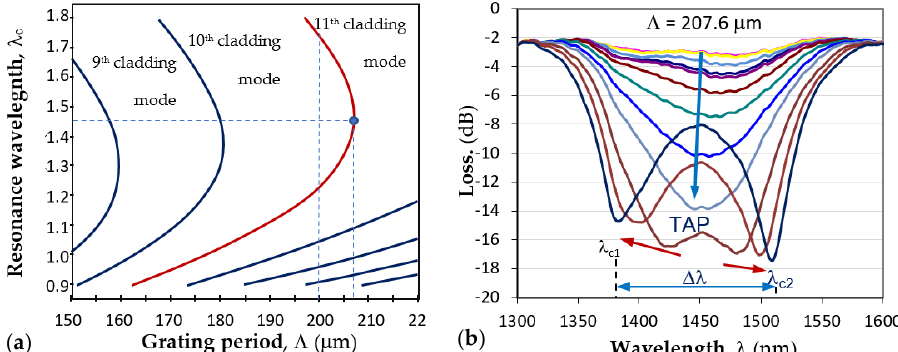
Figure 4. LPG around turning point: ( a ) dispersion dependence and the TAPs of photosensitive fiber PS1250/1500 (Fibercore) for different cladding modes; ( b ) the splitting of a TAP LPG and the transformation into a double resonance grating for the 11th cladding mode.